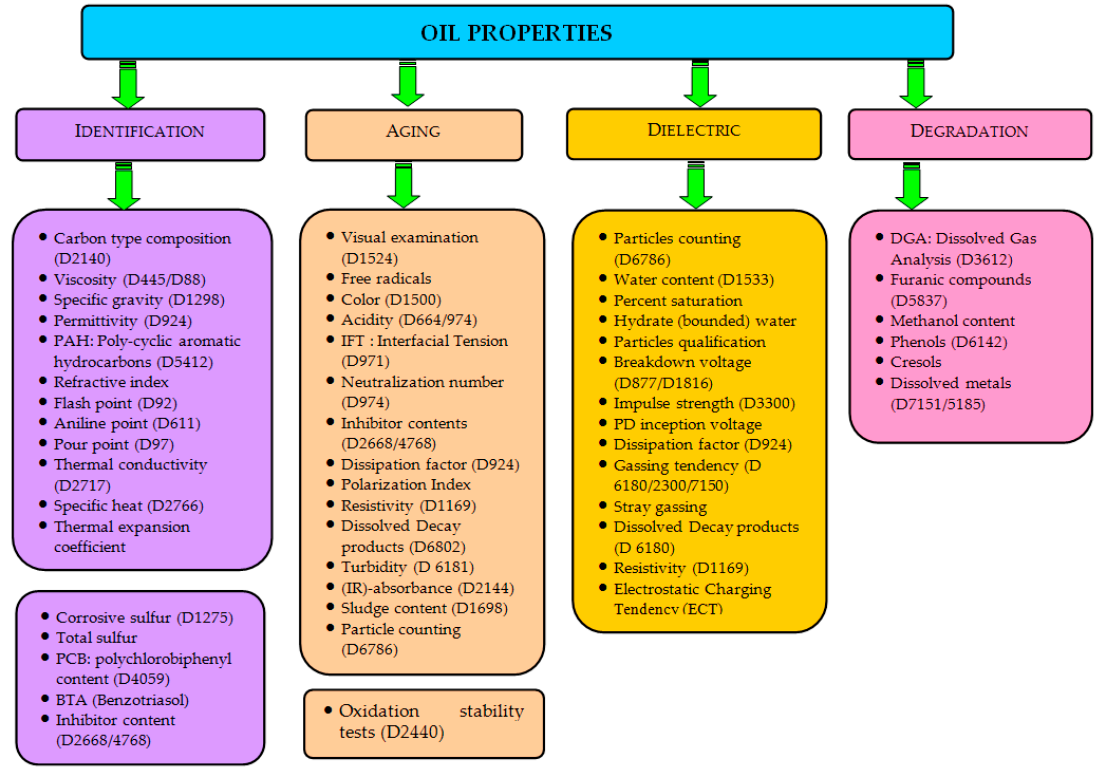
Figure 1. Functional based classification of oil properties adapted from [5]. Specifications in brackets are ASTM (American Society for Testing and Materials) standards. Table 1. Oil condition based on color comparisons [9].